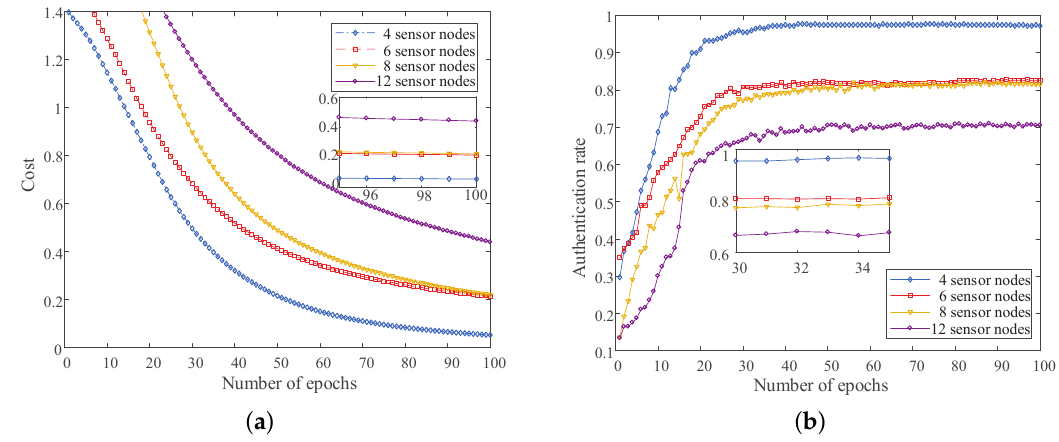
Figure 5. The authentication performance with different sensor nodes. ( a ) The cost value under different numbers of sensor nodes with the DNN-based method; ( b ) The authentication rate under different numbers of sensor nodes with the DNN-based